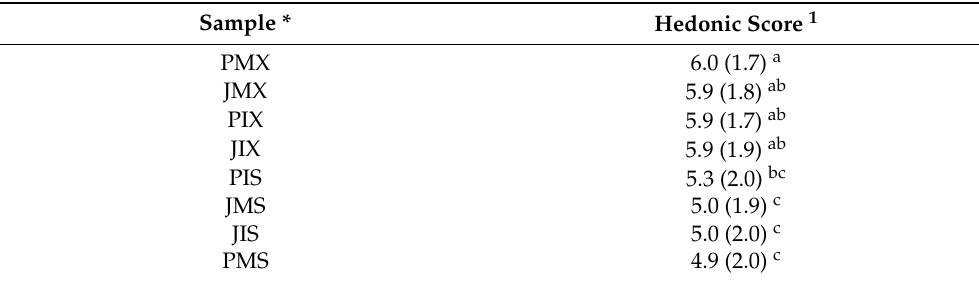
Table 5. Hedonic scores (mean and standard deviation) of the lulo ( Solanum quitoense Lam.) beverage evaluated by consumers ( n =